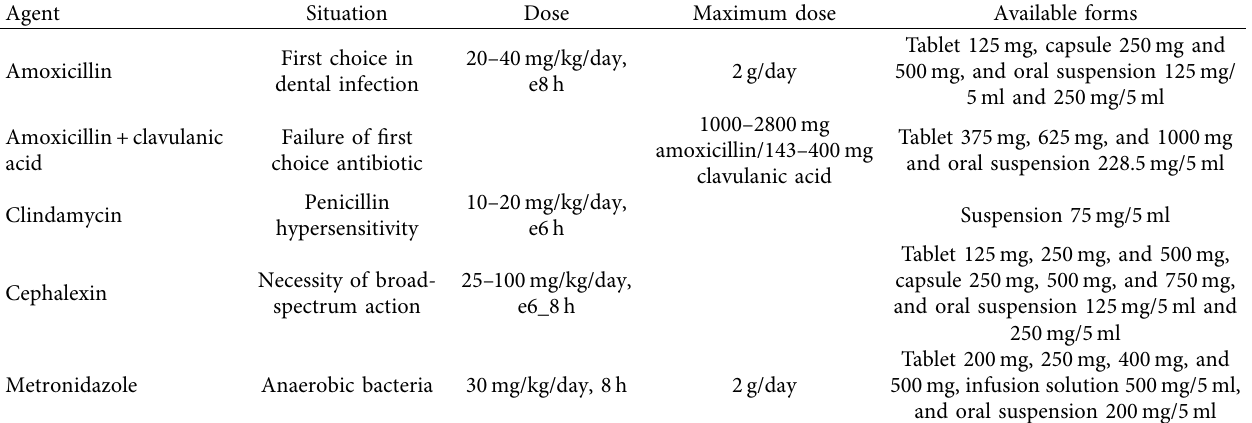
Table 2: Therapeutic antibiotic dose for children.